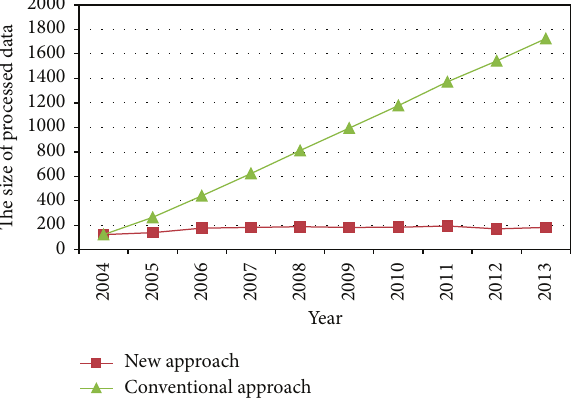
Figure 4: The size of processed